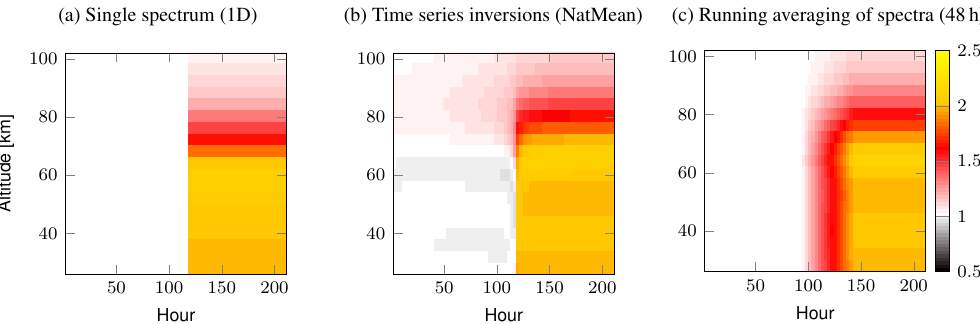
Fig. 2. Retrieved concentrations of water vapour, relative to a priori, from the simulated retrievals. The true water vapour concentration is doubled (i.e. set to two) at the 120th hour. (a) is from the single spectrum (1-D) inversions, (b) from the retrievals using the time series inversion method with the NatMean covariance matrix, and (c) is from the retrievals using spectra averaged over 48h. Sect. 2.3, with S (cid:15) being a pure diagonal matrix and S a having a correlation in both altitude and time.